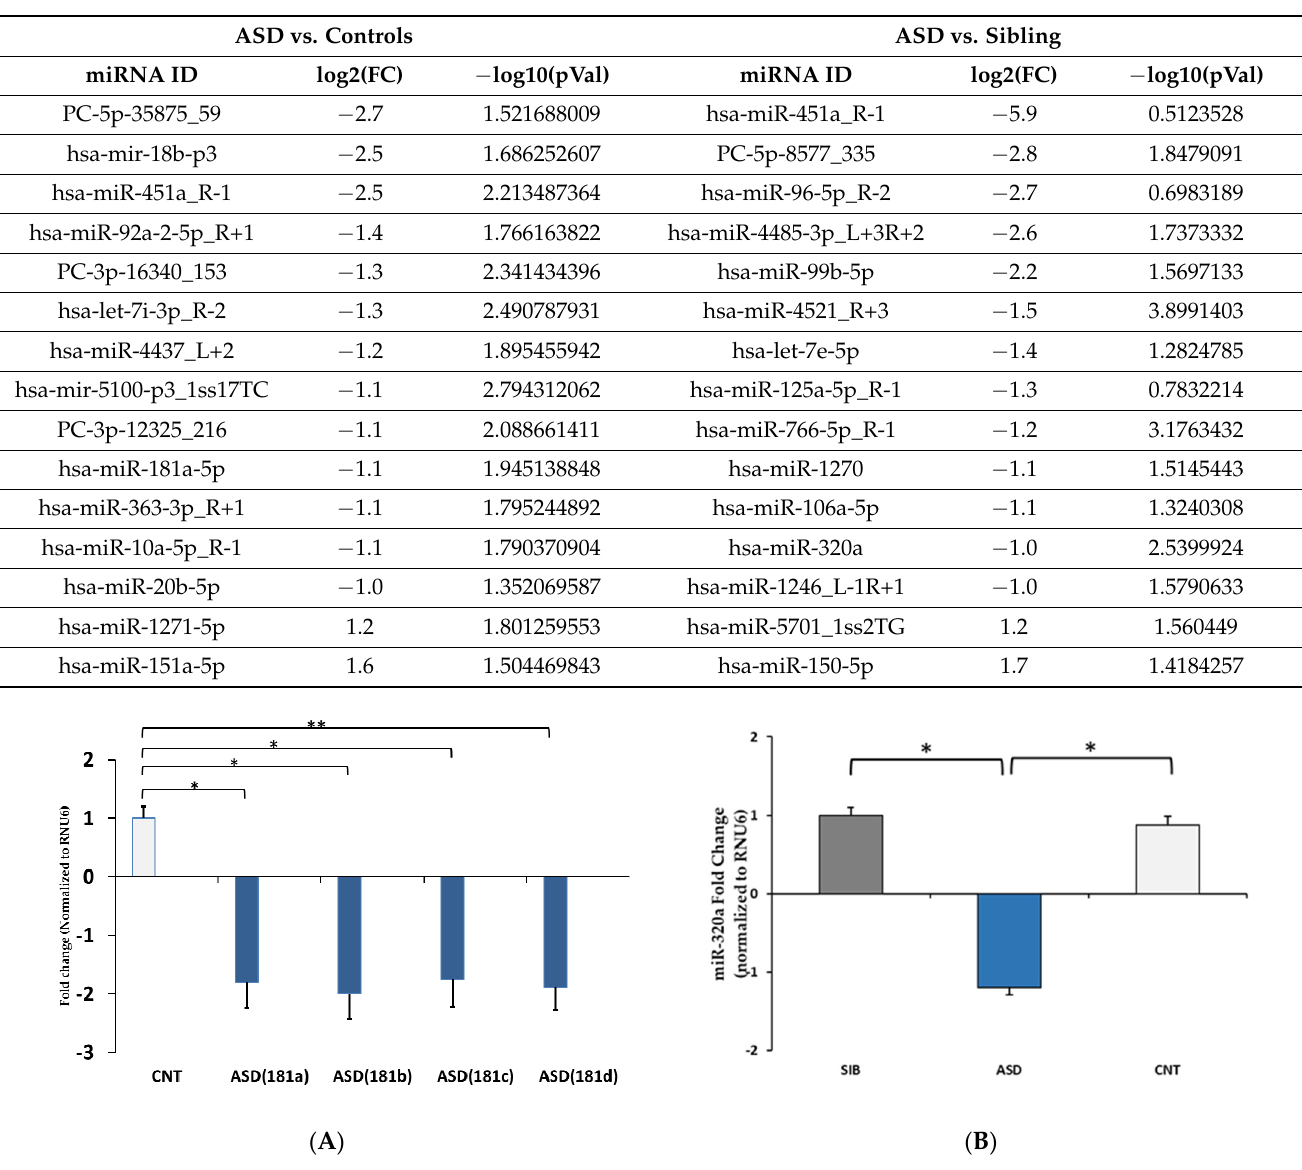
Table 2. Top differentially expressed miRNAs in the ASD vs. control groups and ASD vs. siblings. ASD vs. Controls